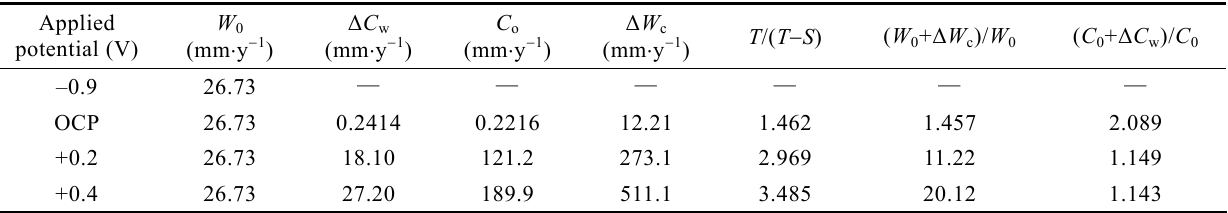
Table 4 Summary of various material loss components for AISI 1045 steel at different applied potentials after sliding under 80 N load and 80 rpm speed.